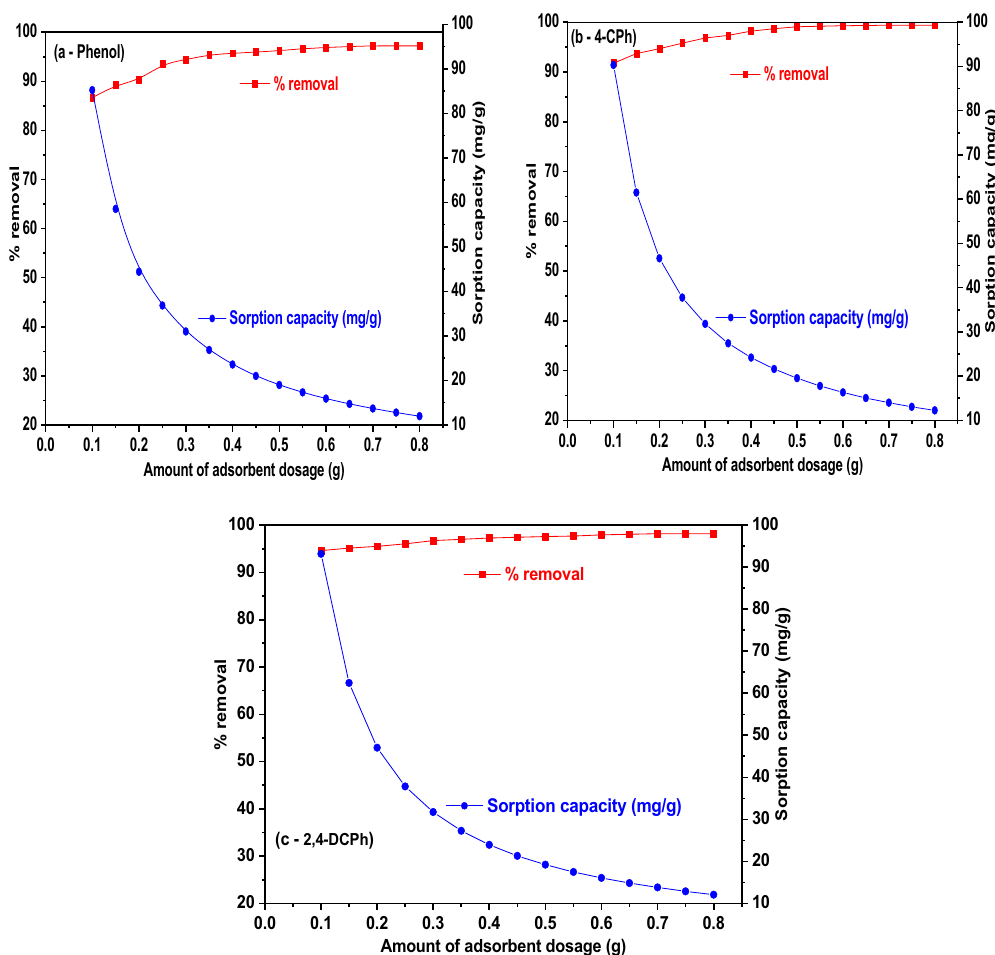
Figure 12. Effect of WAS-BC dose on the sorption of phenol and chlorophenol compounds (a) phenol, (b) 4 - CPh, and (c) 2,4-DCPh. (WAS-BC dosage = 0.1–0.8 g/0.1 L; phenol and CPh concentrations = 100 mg/L; pH = 6.0; agitation time = 150 min and temp = 30 ± 1